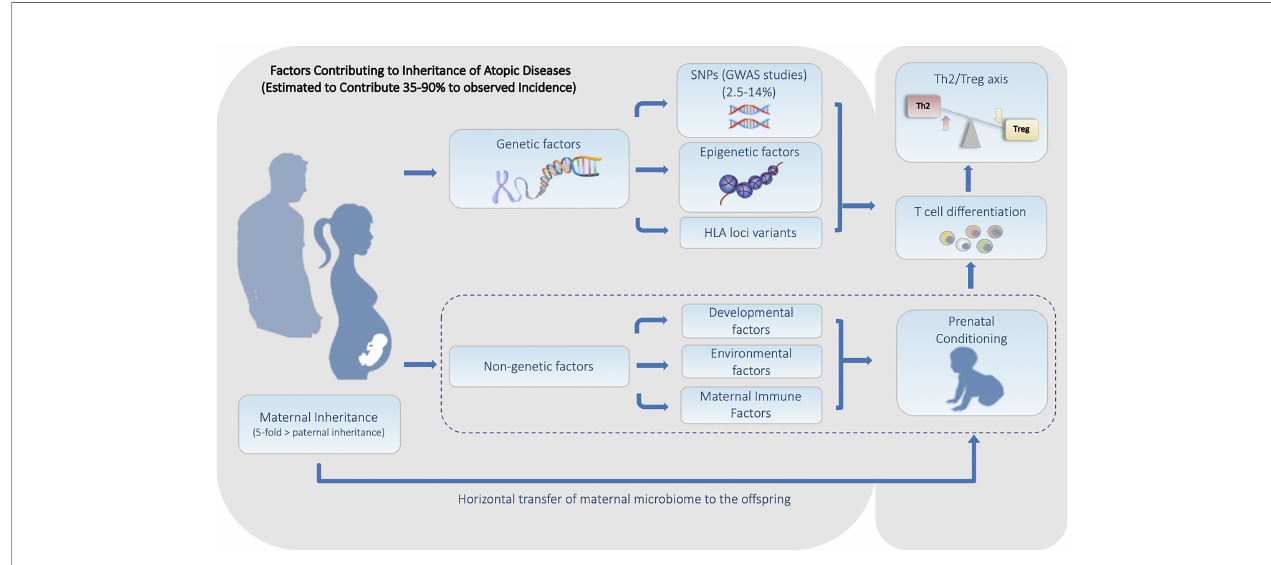
FIGURE 1 | Summary of the Heritable Genetic and Non-Genetic Factors that Contribute to the Predisposition for Atopic Diseases. Factors can be divided into two major categories. (1) Genetic factors including genetically encoded features such as SNPs and HLA haplotype, along with alterable non-genetically encoded epigenetic features including DNA methylation and histone acetylation status. (2) Non-Genetic factors consisting of developmental, environmental, and maternal in fl uences including the maternal microbiome is all transmitted during fetal and/or early neonatal